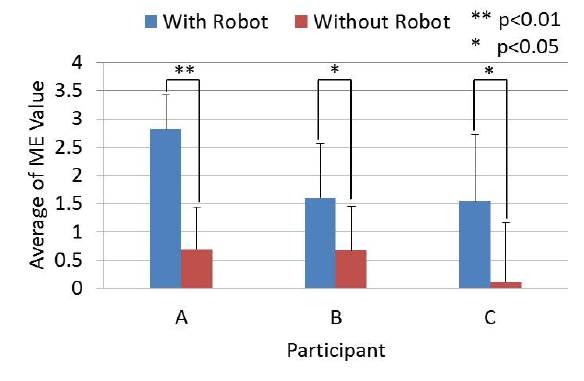
Figure 6. Comparison of average ME